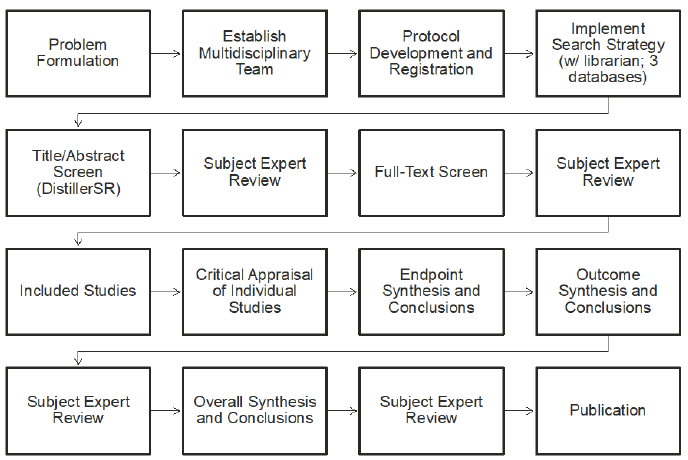
Figure 1. Work flow of the systematic review.